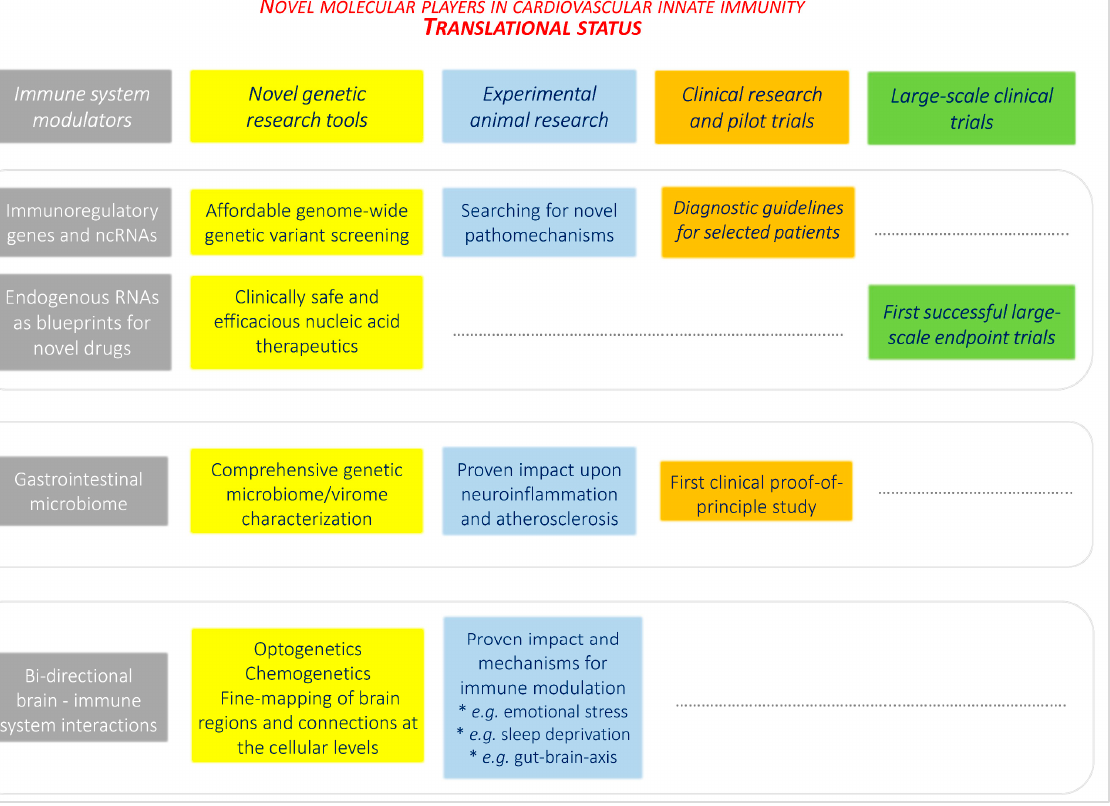
Figure 8. Clinical translational status of the research fields.